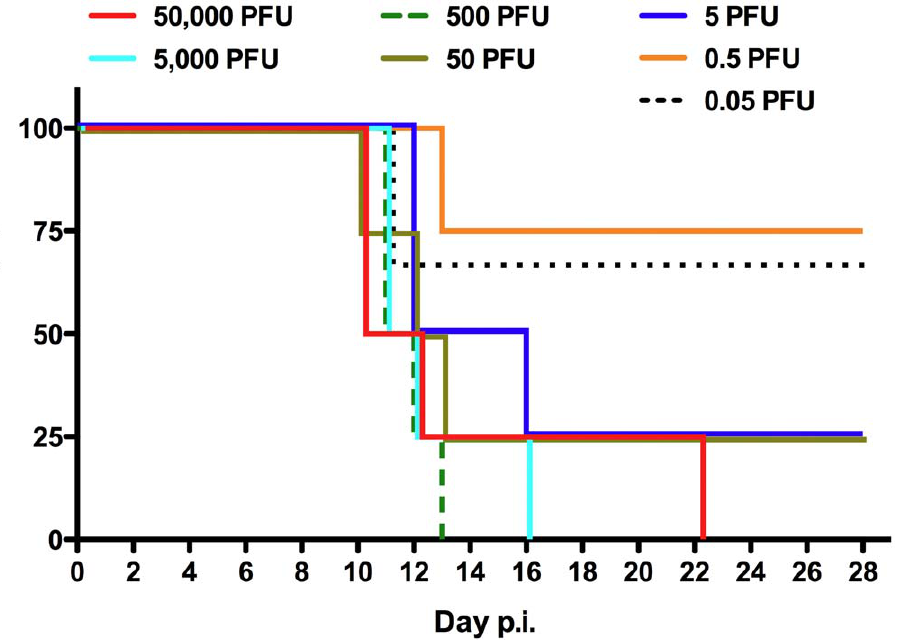
Figure 1. Titration of PICV in outbred guinea pigs. Hartley guinea pigs were challenged i.p. with 50,000, 5000, 500, 50, 5, 0.5 (n=4/group), or 0.05 PFU (n=3) p19 PICV and survival plotted over a 28-day post-infection (p.i.) period. The data are combined from two separate